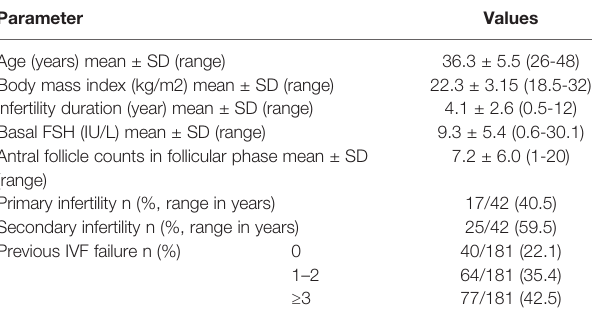
TABLE 1 | Basic characteristics of 42 patients with primarily poor quality embryos in repeated IVF cycles (n = 181). Parameter